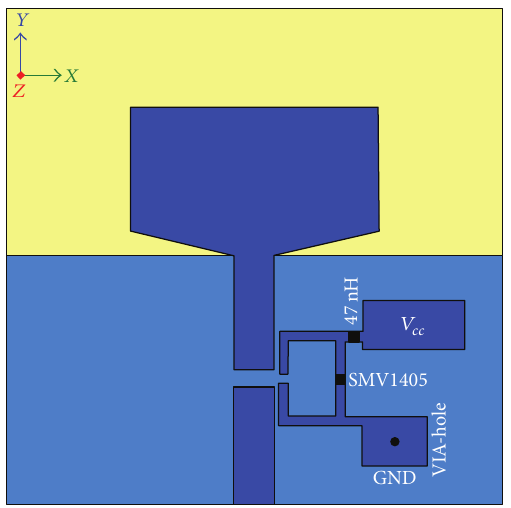
Figure 8: Configuration of the proposed tunable filter-antenna.